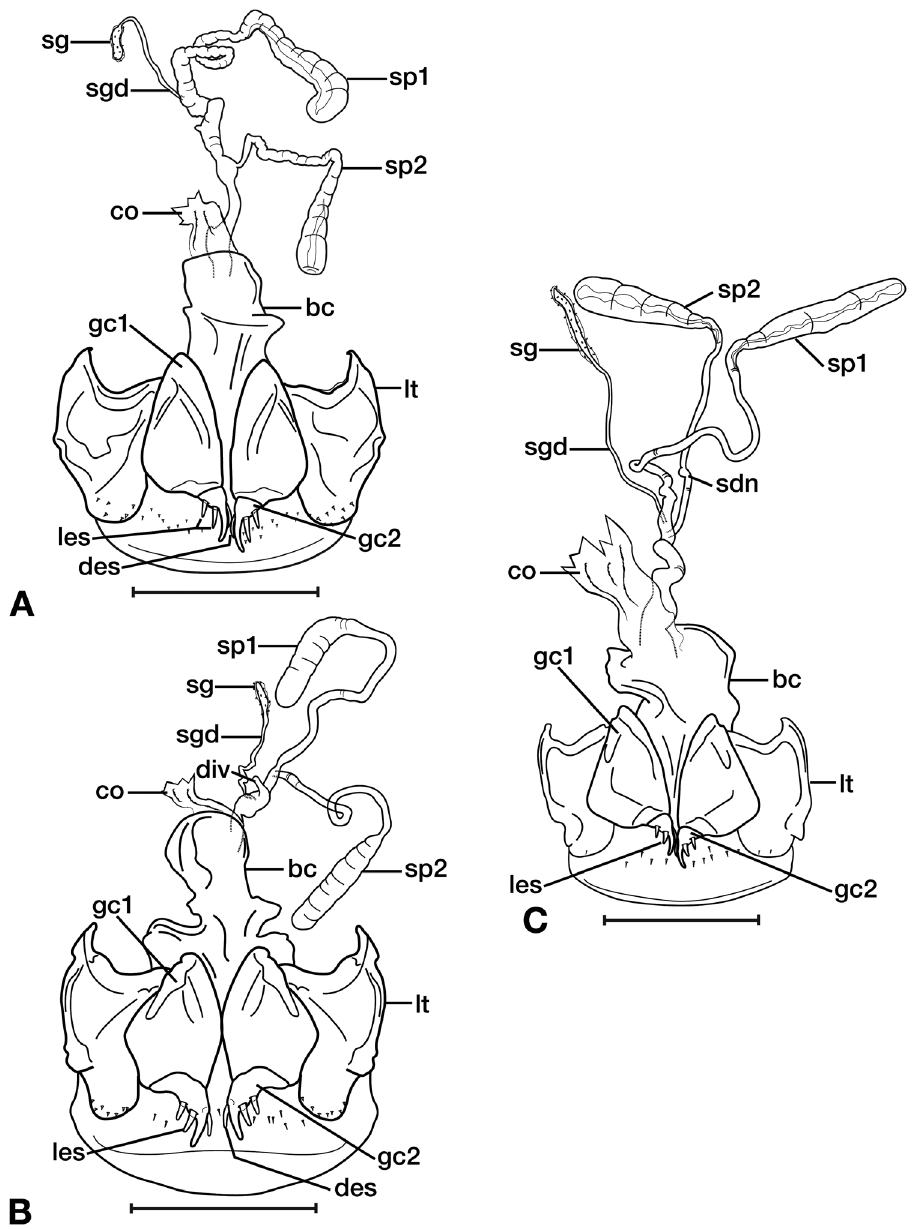
Figure 11. Line drawings of the female reproductive tract of species of the genus Amphimenes Bates, known from Taiwan, ventral aspect. A A. asahinai Nakane B A. absensacidus sp. n. C A. carinacaulis sp. n.. Legend: bc bursa copulatrix; co common oviduct; des dorsal ensiform setae; gc1 gonocoxite 1; gc2 gonocoxite 2; les lateral ensiform setae; lt lateral tergite; sg spermathecal gland; sgd spermathecal gland duct; sp1 spermatheca 1; sp2 spermatheca 2. Scale bars 0.5